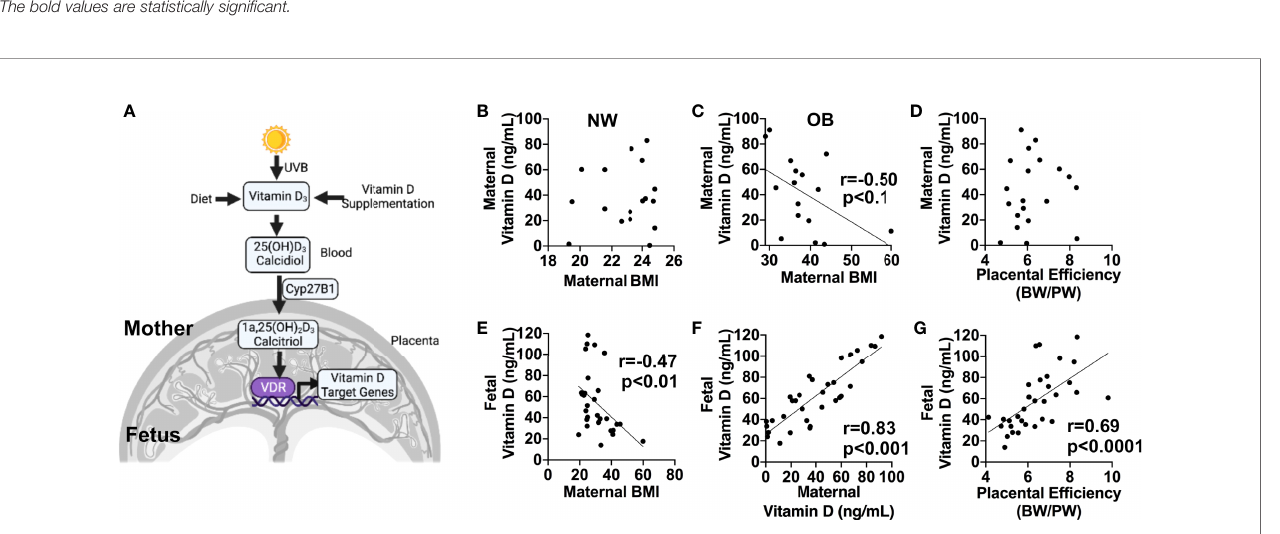
FIGURE 1 | (A) Simpli fi ed diagram showing pathways for Vitamin D synthesis, bioactivation, and function. Created in Biorender.com. (B – G) , 1 a ,25-dihydroxyvitamin D 3 (calcidiol) levels in maternal and cord blood plasma from normal-weight (NW) and obese (OB) women, measured by ELISA. (B – D) , Correlations between maternal blood plasma Vitamin D concentration and maternal pre-pregnancy BMI in normal-weight (B) and obese (C) women, and placental ef fi ciency calculated as the ratio between birth weight (BW) and placental weight (PW) (D) . (E – G) , Correlations between cord blood plasma vitamin D levels and maternal pre-pregnancy BMI (E) , maternal plasma Vitamin D (F) , and placental ef fi ciency (G) . Sample sizes are given in Table 1